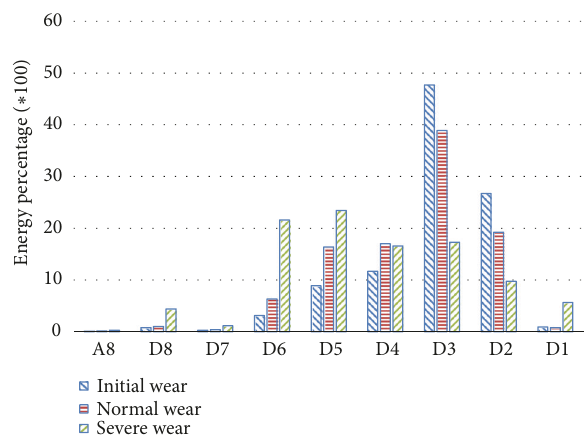
Figure 17: Energy proportion of AE signal after wavelet decompositions in each frequency band.